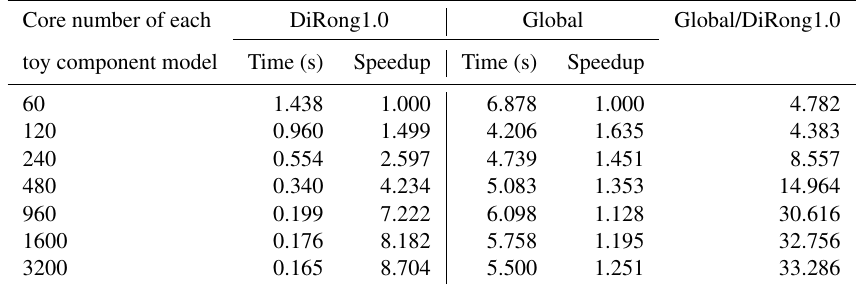
Table 10. Performance of DiRong1.0 and the comparison with the original global routing network generation (Global) using different numbers of cores numbers and the grid size of 32000000.